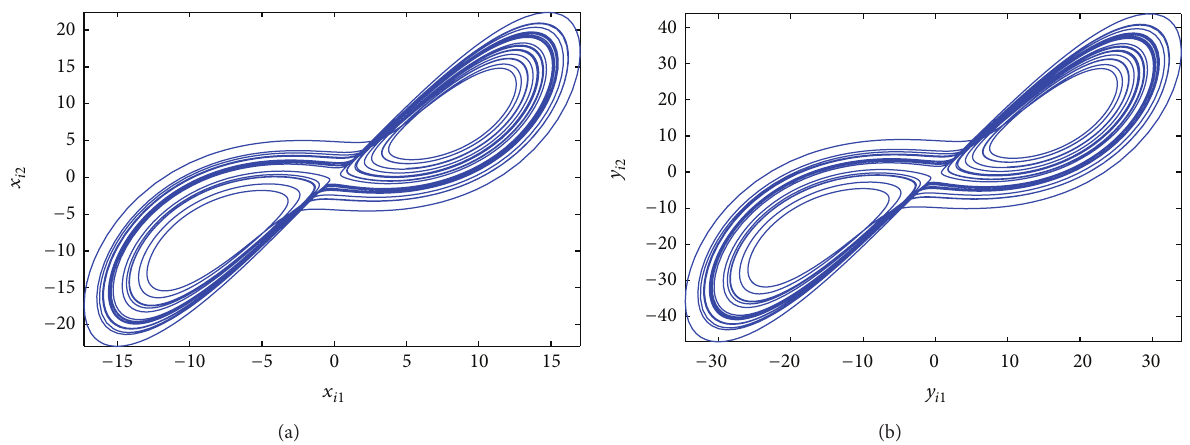
Figure 9: Phase plane diagrams for node 3, where (𝑦 𝑖1 ,𝑦 𝑖2 , 𝑦 𝑖3 ) = (2𝑥 𝑖1 , 2𝑥 𝑖2 − 1, 𝑥 𝑖3 ) . (a) Projection in the (𝑥 𝑖1 , 𝑥 𝑖2 ) plane of node 3 in the drive network. (b) Projection in the (𝑦 𝑖1 ,𝑦 𝑖2 ) plane of node 3 in the response network.